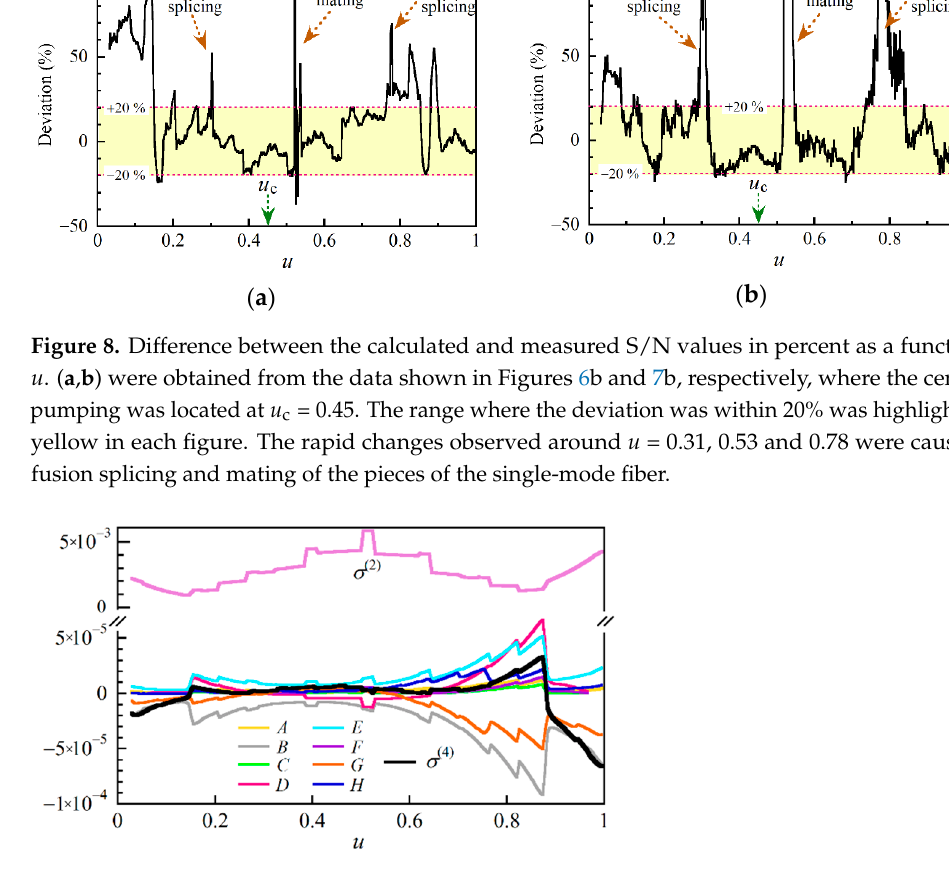
Figure 9. Numerical calculation of the constituent terms A to H of the correction term σ (4) together with σ (2) when current source A was used, where the center of pumping was located at u c = 0.45. We calculated σ (4) to improve the discrepancy between the measured and calculated data observed in Figure 6b.